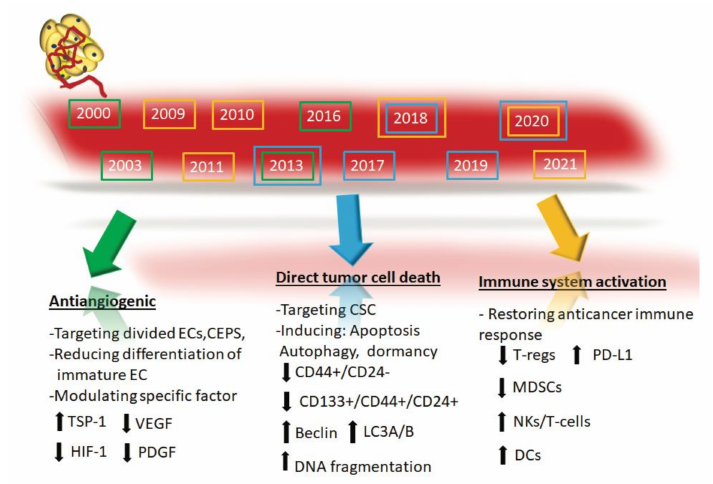
Figure 1. Timeline showing the discovery of the main impacts of the metronomic schedule. 1. Antian- giogenic: inhibiting the proliferating and the circulation of endothelial cells (EC) and by modulating the pro-and-antiangiogenic factors; 2. direct tumor cell death: targeting cancer stem cells (CSC) and inducing apoptosis, autophagy, and tumor dormancy; 3. activation of the anticancer immune response. These multiple mechanisms delineate metronomic as multitarget